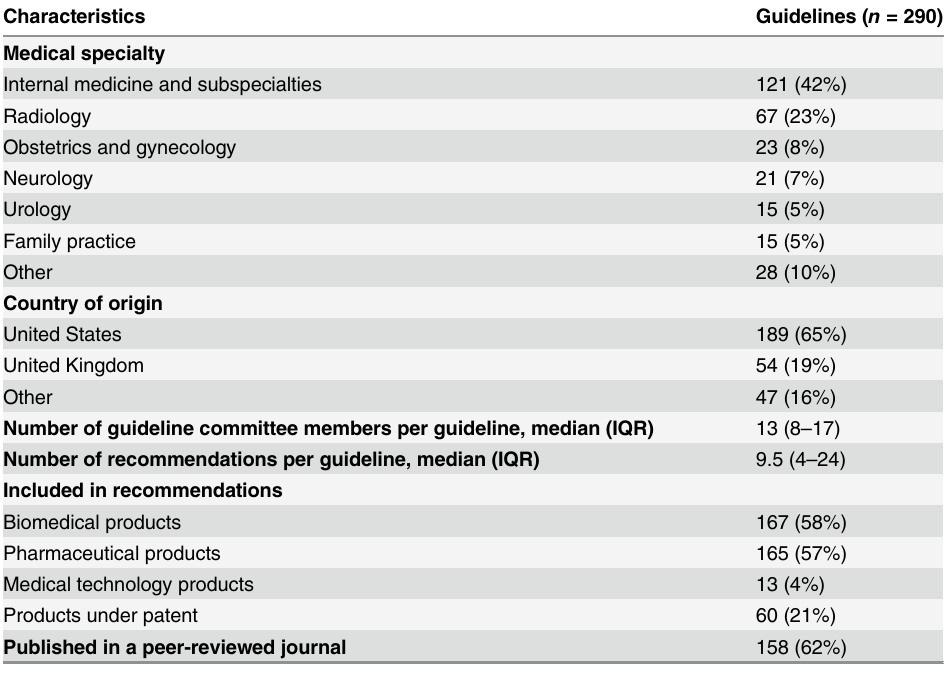
Table 3. Characteristics of the clinical practice